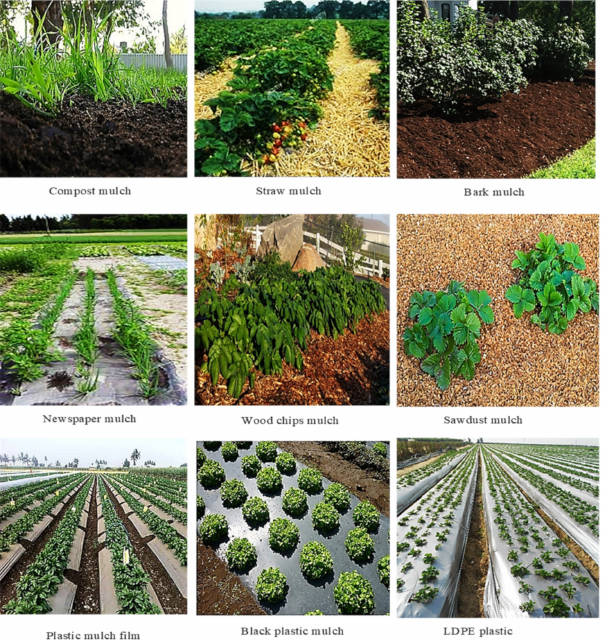
Figure 4. Different types of mulching